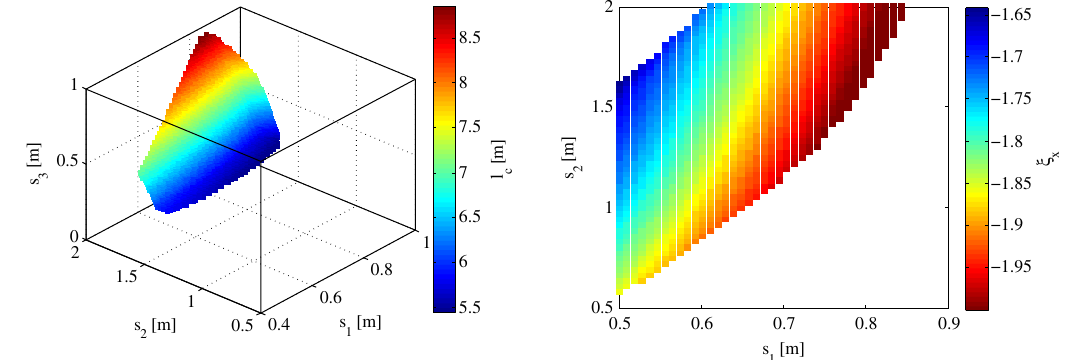
≤ − 2 ), color-coded with the total x;y